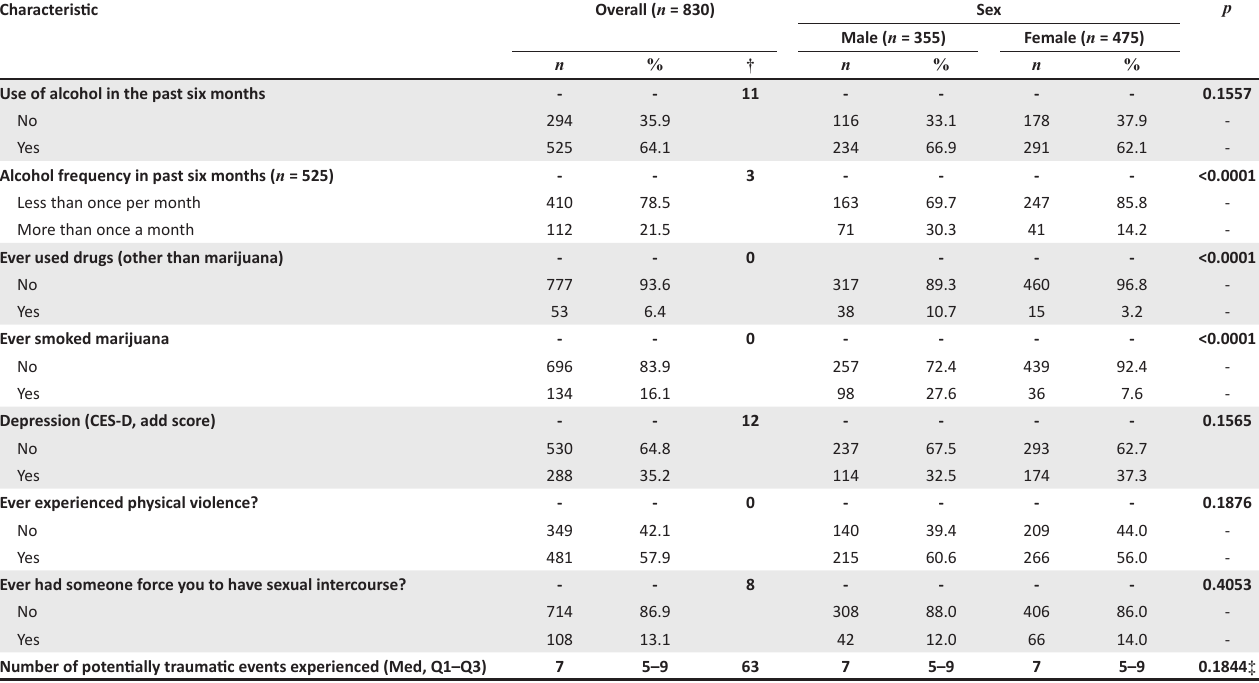
TABLE 4: Alcohol use, drug use, trauma experiences and depression symptomatology among Botsha Bophelo Adolescent Health Study participants ( N = 830). Characteristic